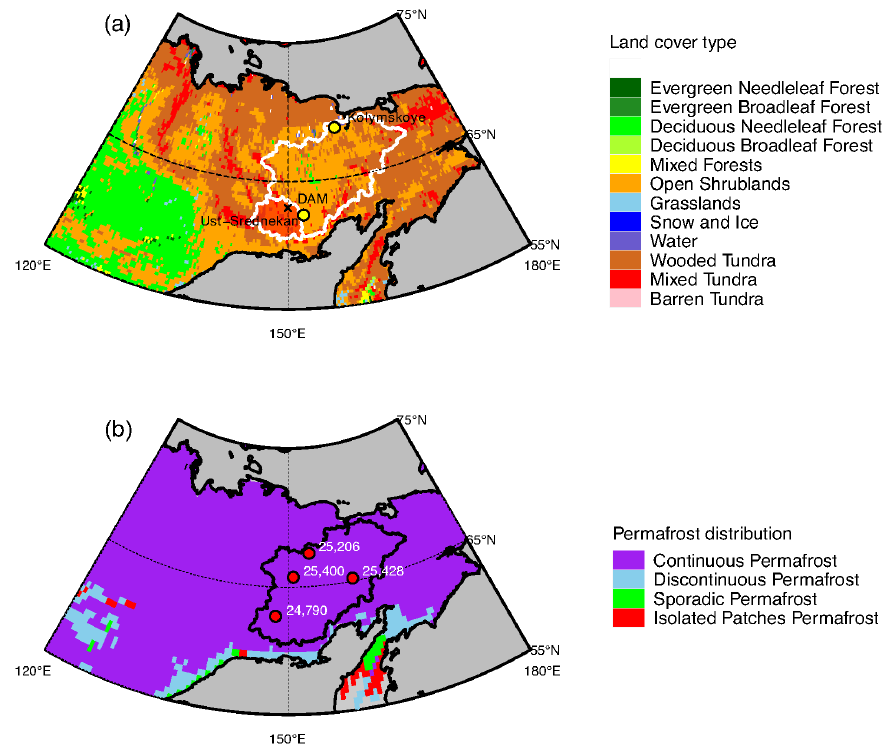
Figure 1. Maps of geographical characteristics in the Kolyma River basin: ( a ) Vegetation (the 1 ◦ GLDAS-2/NOAH Dominant Vegetation Type datasets (https://ldas.gsfc.nasa.gov/gldas/ GLDASvegetation.php accessed on 30 July 2021) using the NOAHv3.3 Vegetation Dataset from GLDAS-2) and ( b ) Permafrost distribution [19]. White and black lines denote the Kolyma River watershed boundary (total basin). Red area in ( a ) shows a sub-basin “Dam basin.” In ( a ), yellow circles denote the locations of river discharge cross-sections, and black cross-mark denotes a large reservoir. In ( b ), red circles and white numbers denote meteorological observation sites, which include soil temperature profile observation at 20 cm, 40 cm, 80 cm, 160 cm, and 320 cm